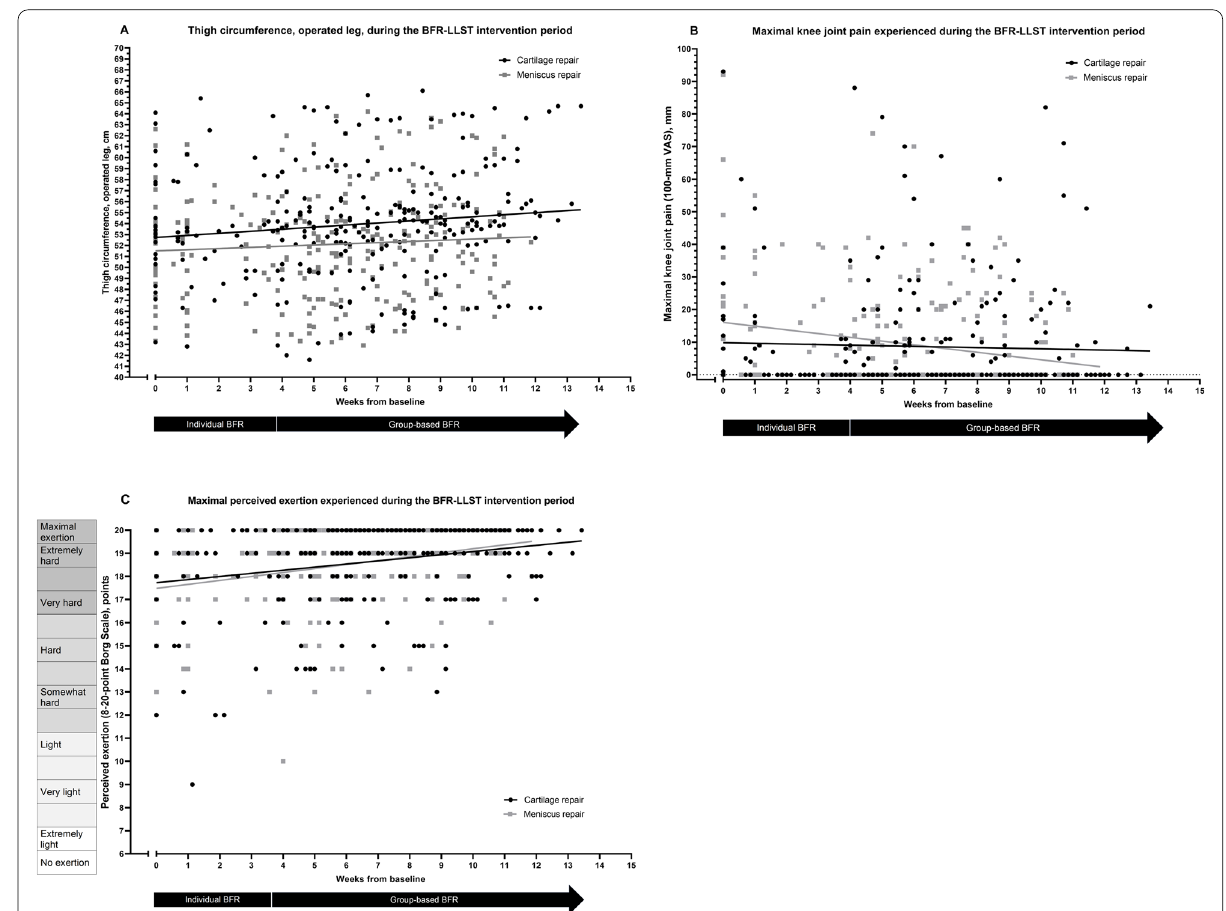
Fig. 3 Scores of each patient and mean scores for the patients with cartilage (black dots and line) or meniscus repair (gray dots and line) over time for thigh circumference ( A ), knee joint pain ( B ) and perceived exertion ( C ) during the BFR-LLST intervention. BFR-LLST; Blood flow restriction – low load strength training. VAS; Visual Analogue